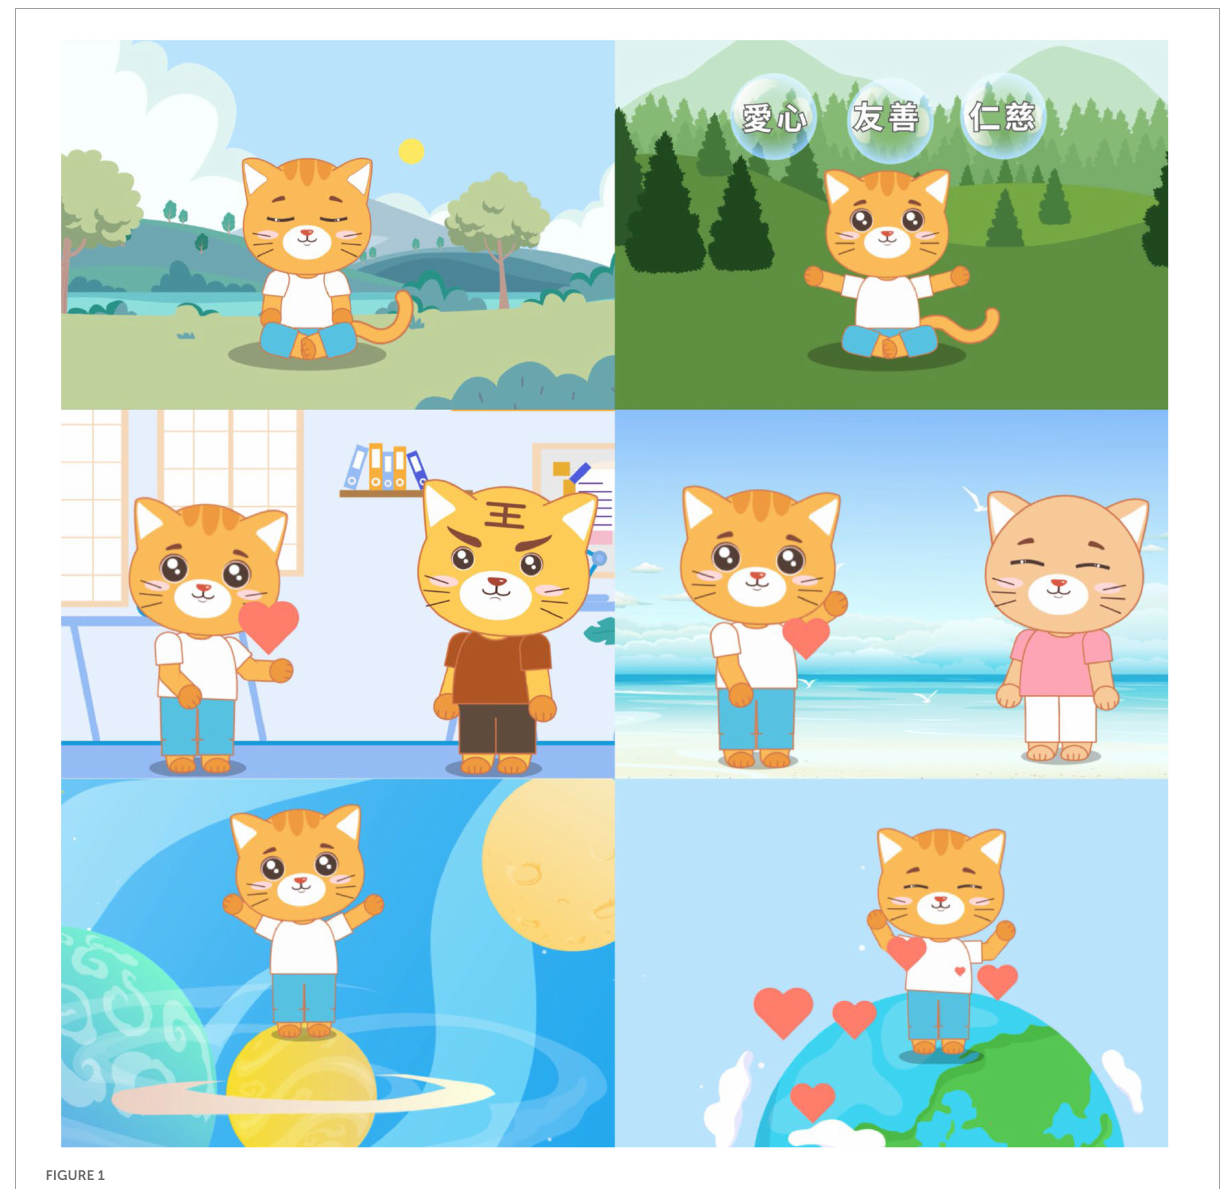
FIGURE1 Animated pedagogical agent (APA) cartoon image